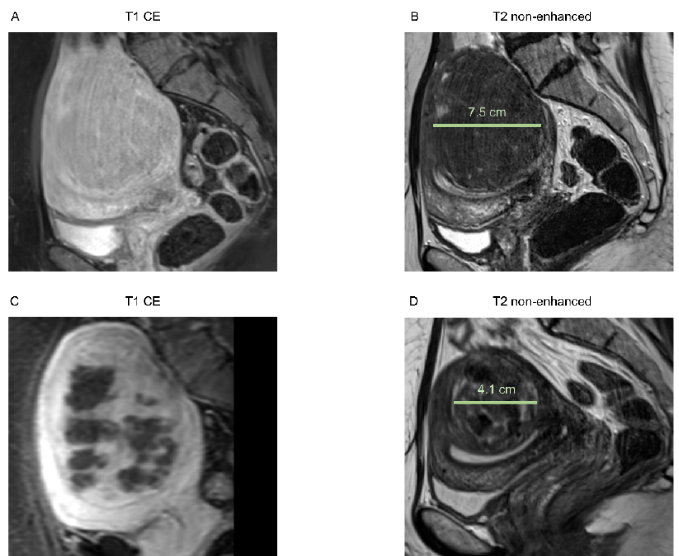
Figure 1. Images of a 51-year-old patient with solitary intramural uterine fibroid in the posterior wall, Funaki grade 2. ( A ) Contrast-enhanced T1-weighted and ( B ) T2-weighted images 2 weeks before HIFU treatment, sagittal reformation. Pre-interventional maximum diameter was 7.5 cm. ( C ) Immediate post ‐ interventional T1 contrast ‐ enhanced image with a volumetric assessed NPV of 61%, sagittal reformation. ( D ) T2 ‐ weighted image 6 months after intervention with a maximum diameter of 4.1 cm, sagittal reformation.